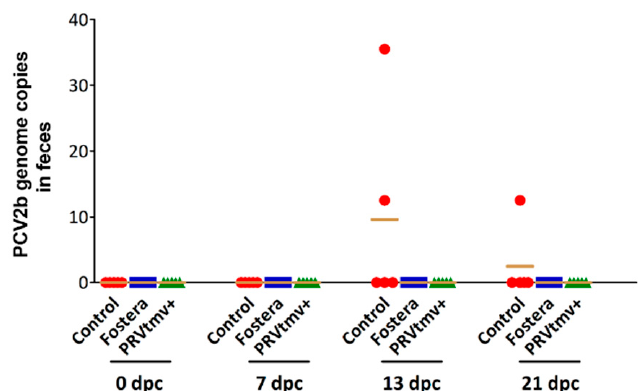
Figure 15. Fecal PCV2b shedding in control and vaccinated pigs following the PCV2b challenge was assessed by qPCR. DNA was isolated from fecal swab, and PCV2b qPCR was performed. PCV2b genome copy numbers were calculated according to CT ‐ values of a standard curve. The mean copy numbers of PCV2b genome are shown in 200 ng of DNA of two independent qPCR analyses of each animal from the three vaccination groups on 0, 13, 17, and 21 dpc. The dot plot graph represents mean + individual values in each group ( n = 5). dpc—days post ‐ challenge.